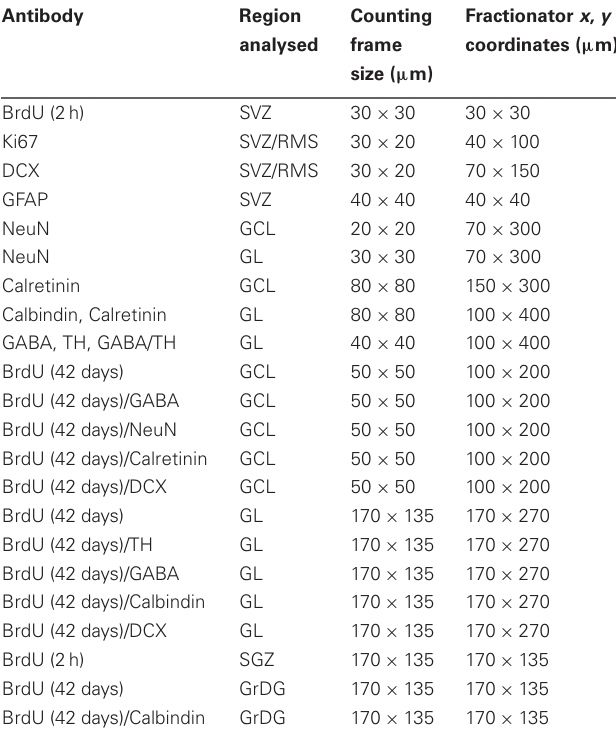
Table 1 | Counting frame dimensions and x , y co-ordinates for estimates of proliferating cells (Ki67, BrdU 2h), migrating neuroblasts (DCX), interneurons, and mature cells (NeuN, TH, calbindin, calretinin, GABA, BrdU 42 days) in the SVZ, RMS, OB, SGZ, and